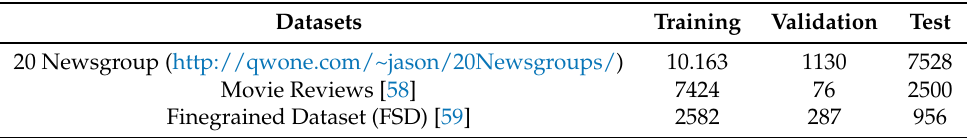
Table 2. Test collections for experiments on the use of generative adversarial networks to learn distributed representations of natural language at the document, sentence, and aspect